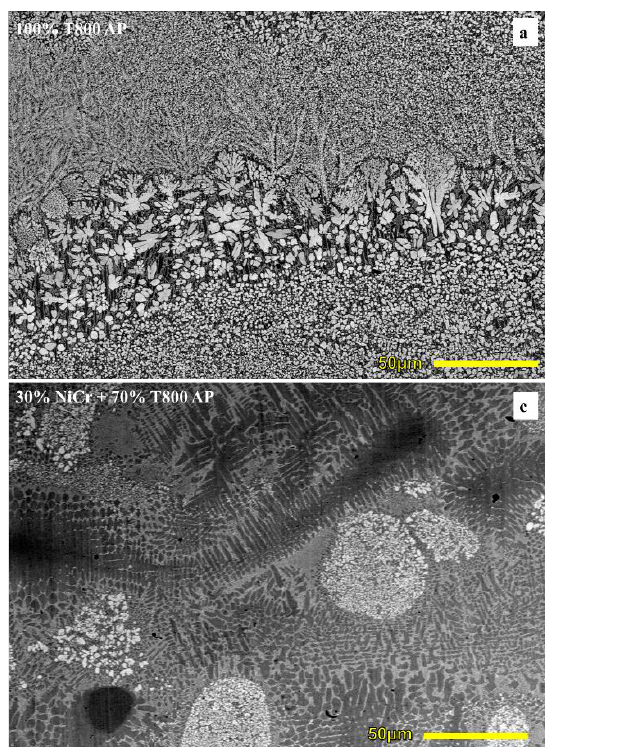
Figure 3. SEM microstructure results of as processed (AP) samples. ( a ) 100% T800, ( b ) T800 + 20% NiCr, ( c ) T800 + 30% NiCr, and ( d ) T800 + 40% NiCr.